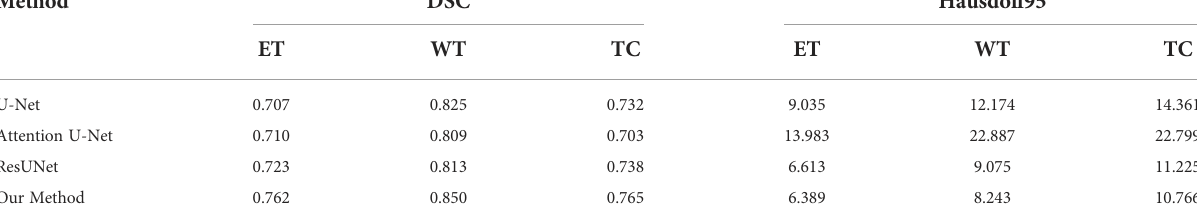
TABLE 4 Comparative results on BraTS 2020